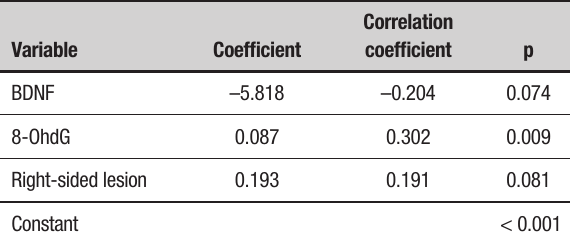
Table 4. Multiple analysis using linear regression of serum level with post- stroke